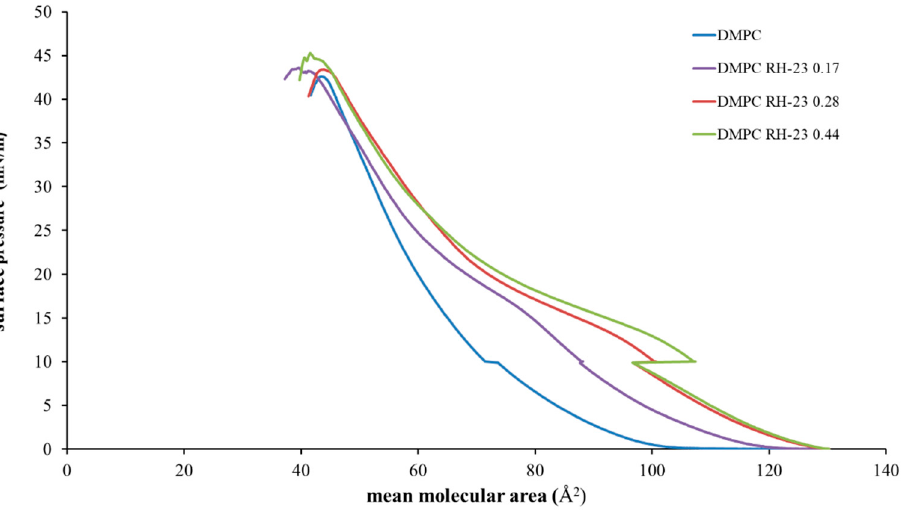
Figure 5. Surface pressure (mN/m)/mean molecular area (Å 2 ) isotherms of DMPC monolayers in the presence of RH-23 at different molar fractions in the subphase with a pause of 30 min at 10 mN/m, at a temperature of 37 °C and pH 7.4.